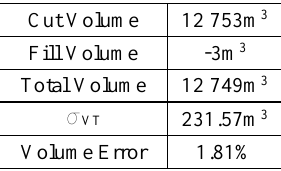
Table 7. Total Volume of the stockpile computed in Civil